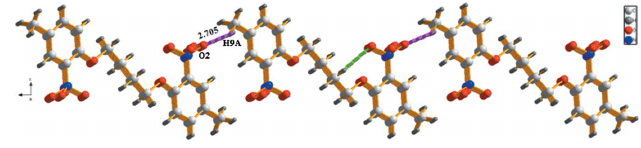
Figure 3 A view along the c axis of the crystal packing of the title compound. The C9—H9 A (cid:2)(cid:2)(cid:2) O interactions are represented by purple dashed lines.